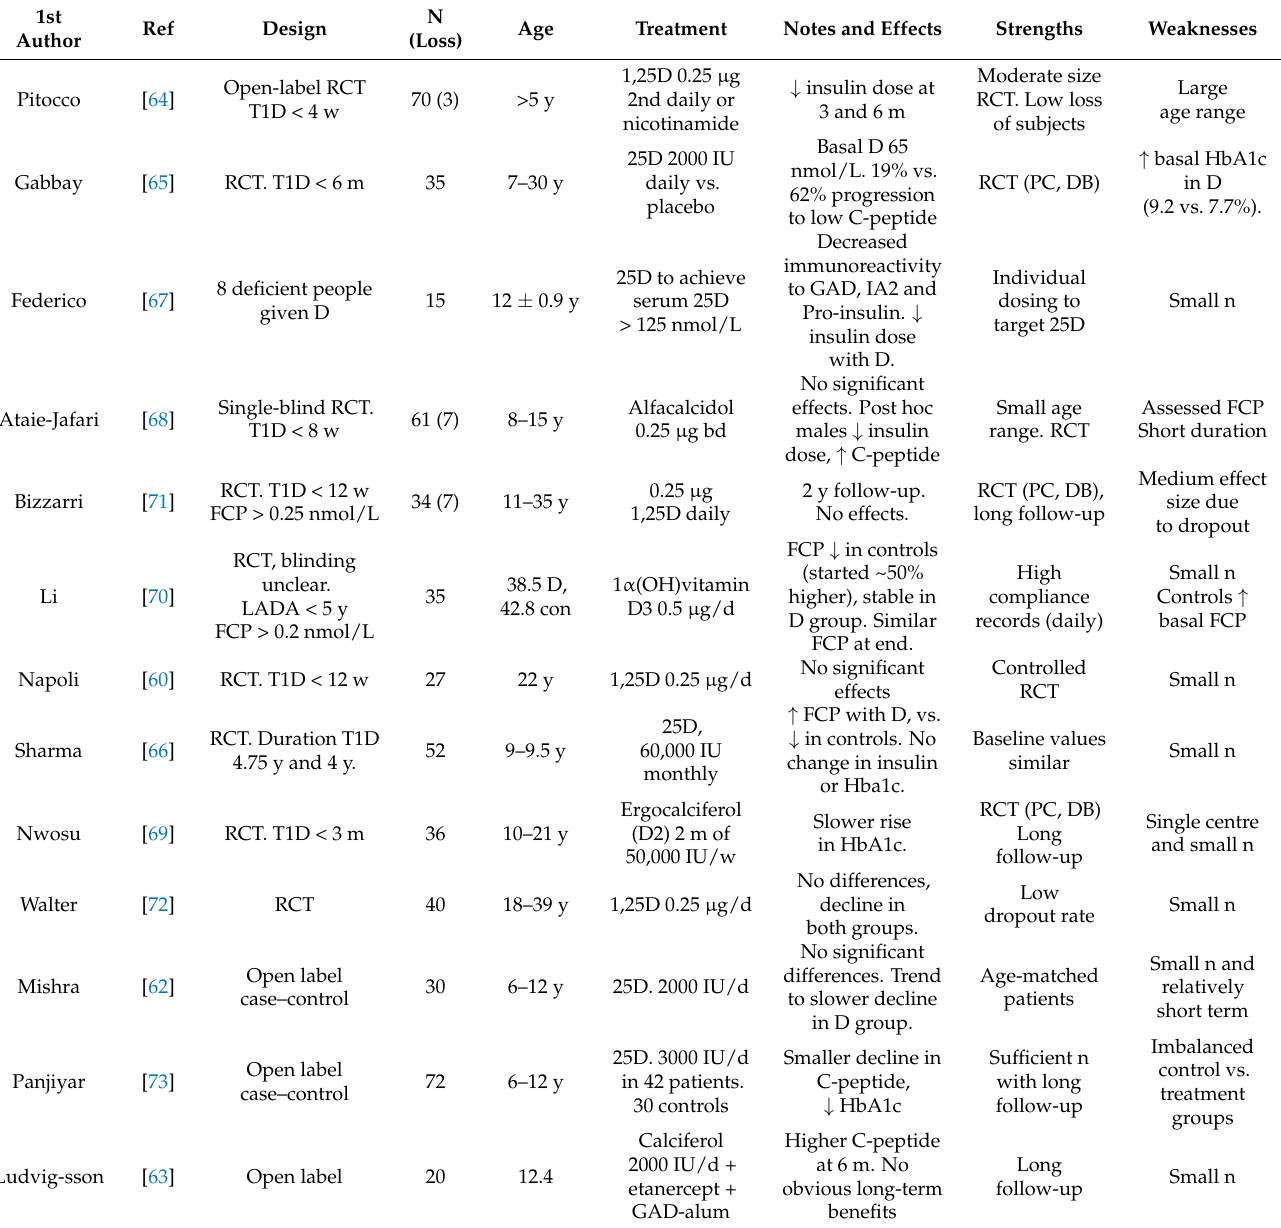
Table 2. Human therapeutic trials of vitamin D and